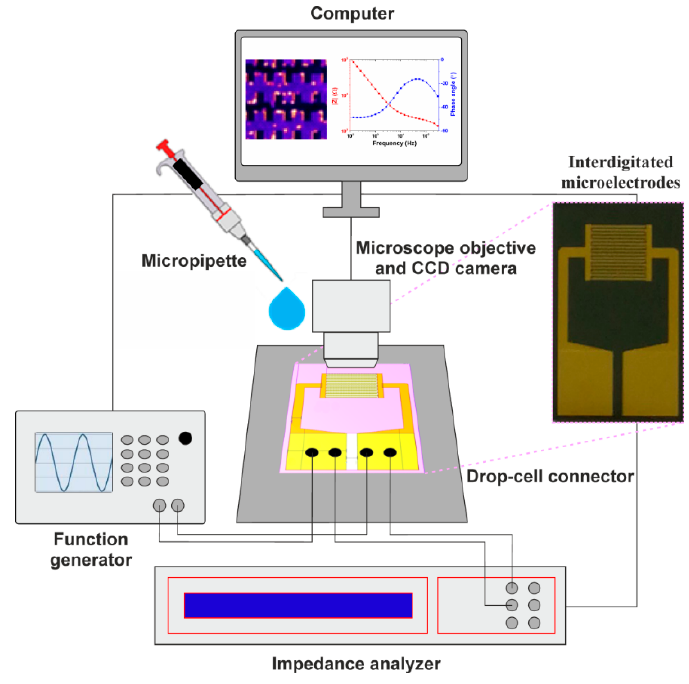
Figure 1. Experimental